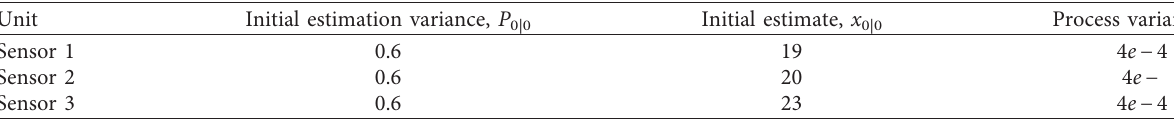
Figure 8: Variance curve of the filtered fusion data source. Table 1: Initial parameters of the discrete Kalman filter.